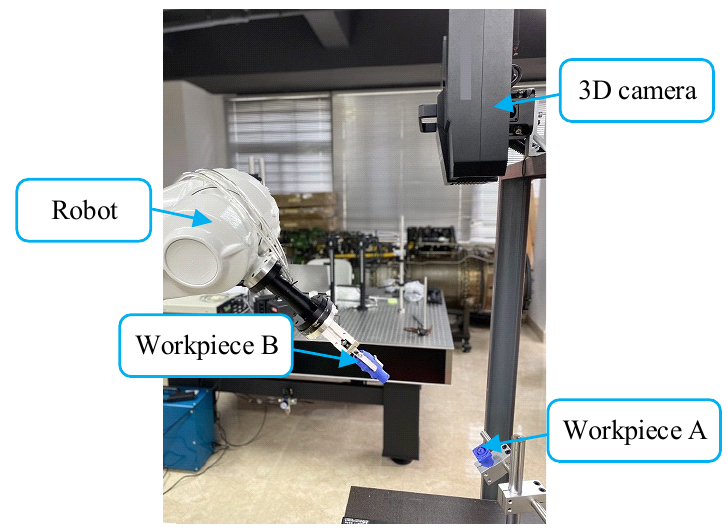
Figure 20. Automatic assembly system experiment.